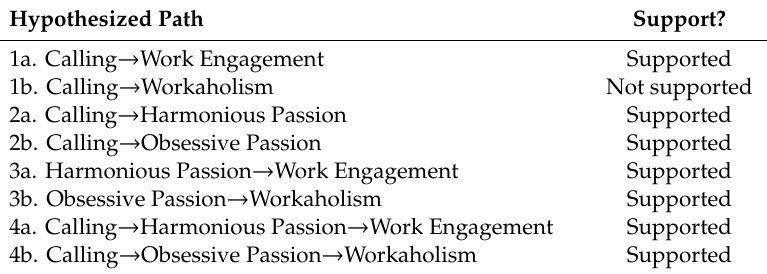
Table 3. Hypothesis testing from the structural